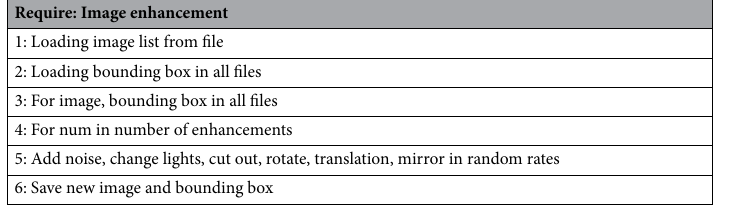
Table 2. Data enhancement algorithm.